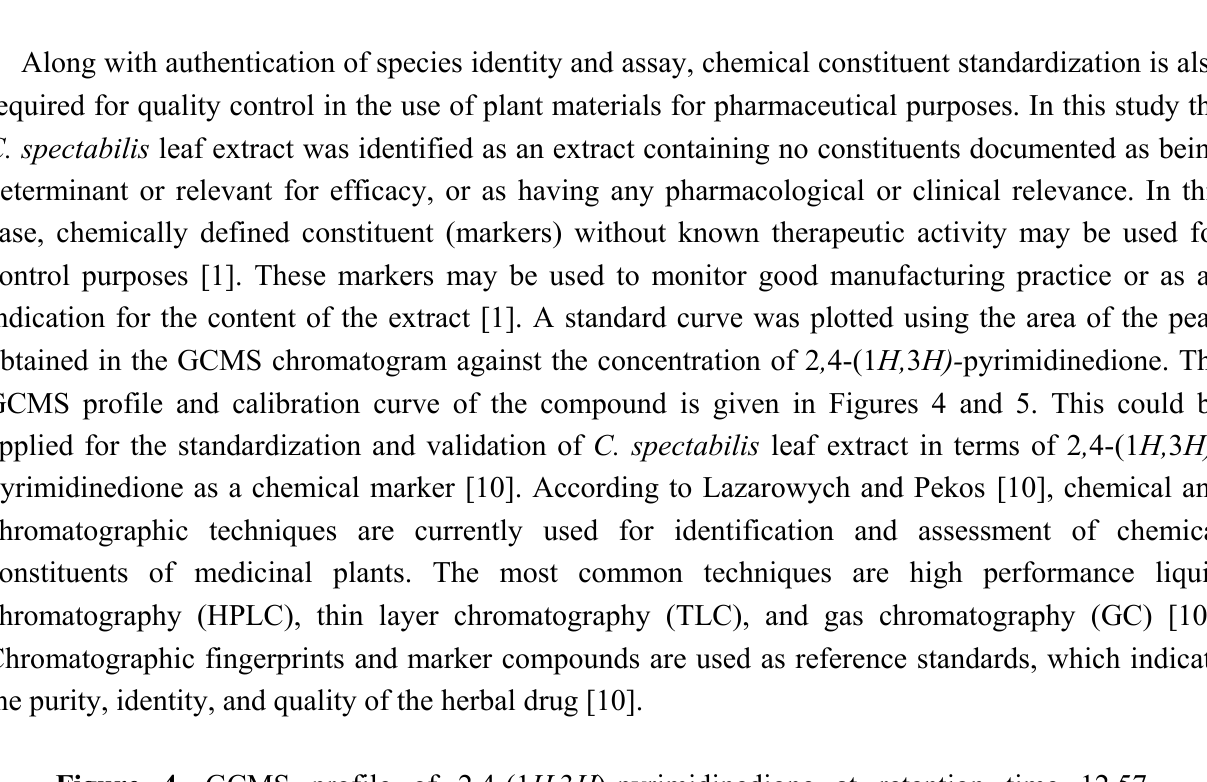
Figure 4. GCMS profile of 2 , 4-(1 H, 3 H ) - pyrimidinedione at retention time